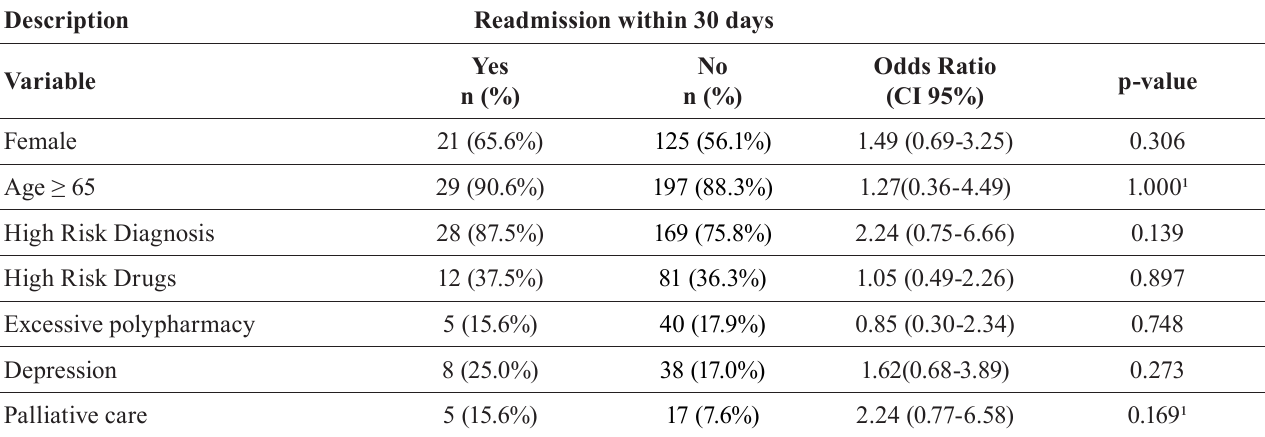
TABLE I - A ssociation between clinical pharmacotherapeutic characteristics used in the calculation of Readmission Risk Score